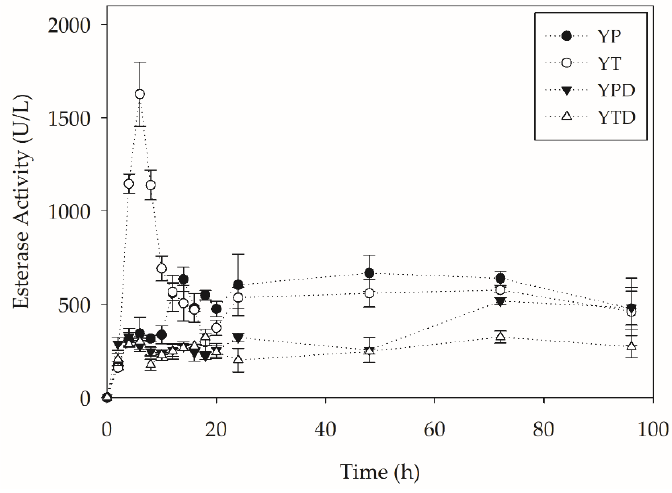
Figure 4 . Esterase activity during PC-PET biodepolymerization by submerged cultures of Y. lipolyt- ica IMUFRJ 50682 at 28 °C and 250 rpm for 96